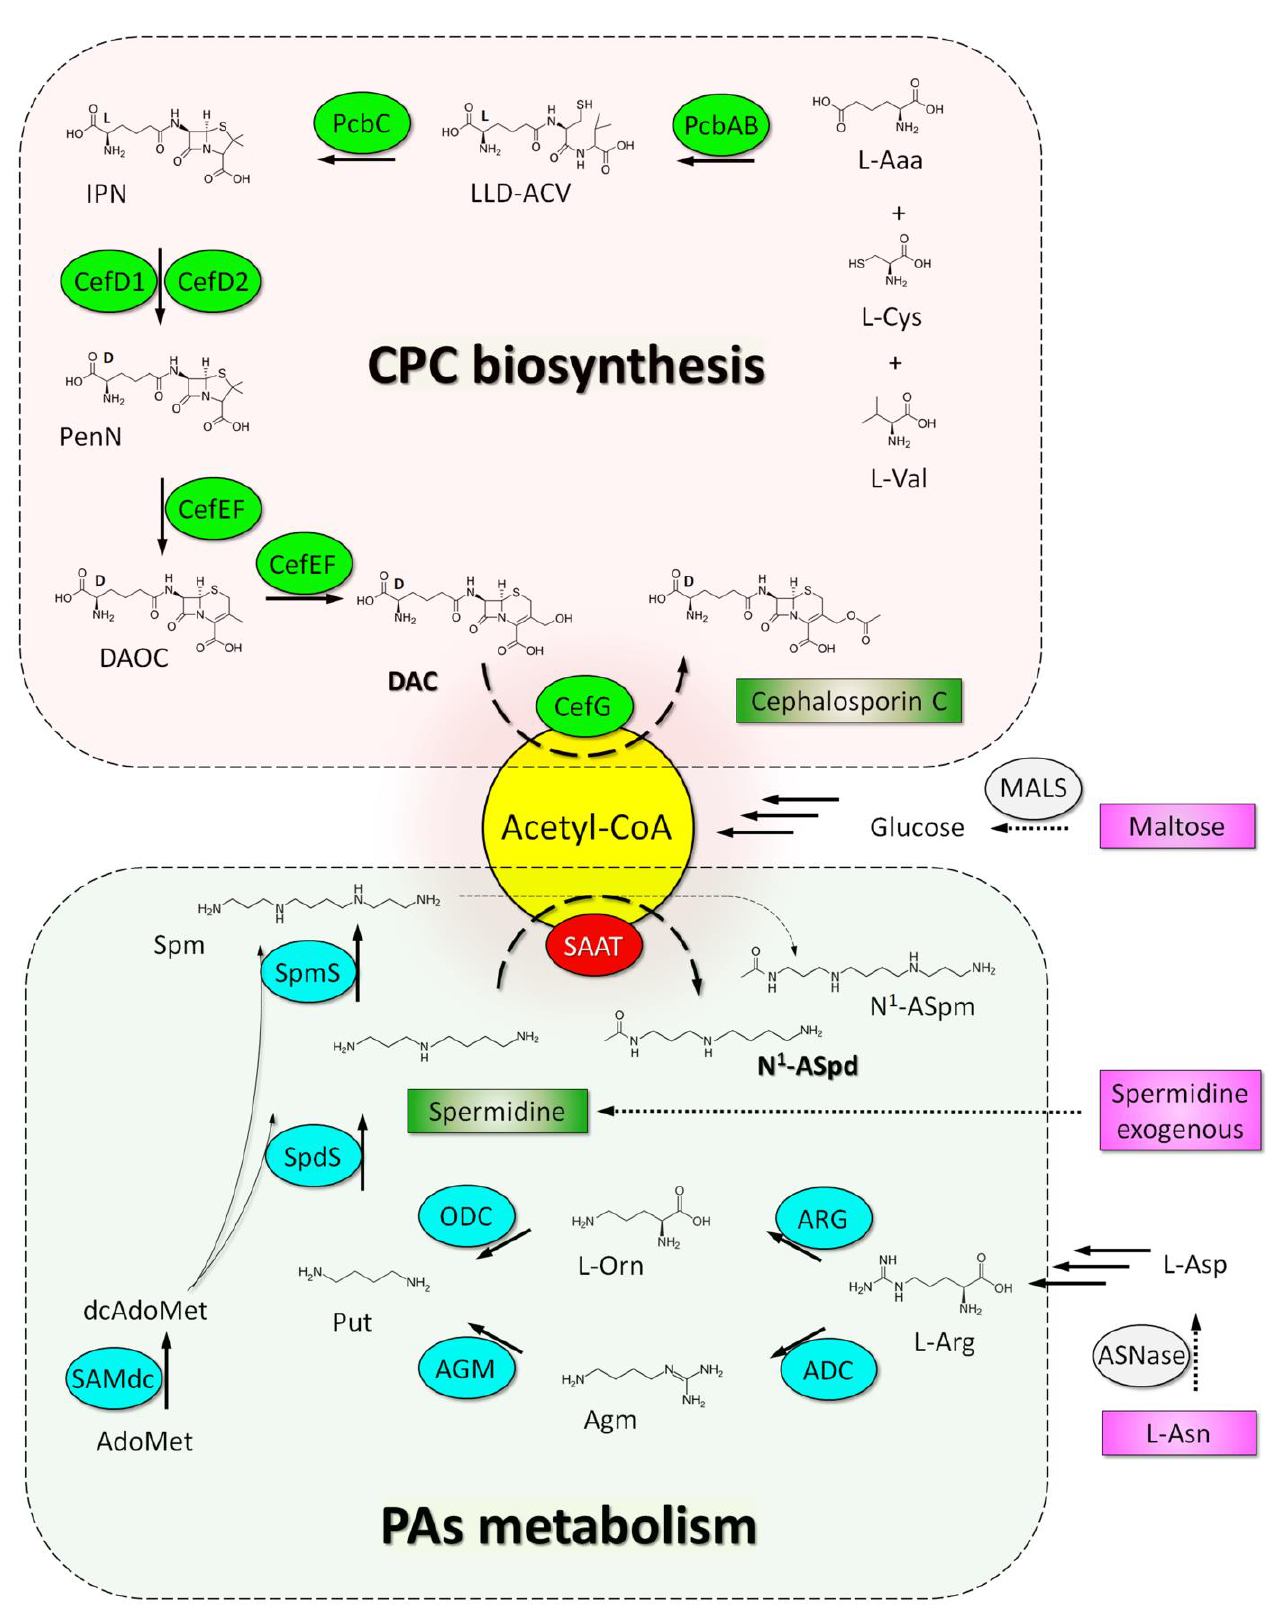
Figure 10. Proposed mechanism for intersection of cephalosporin C (CPC) biosynthesis and polyamine (PAs) catabolism at the level acetyl-coenzyme A (Acetyl-CoA) consumption during cultivation of A. chrysogenum high-yielding (HY) strain on synthetic (SN) medium, supplemented with